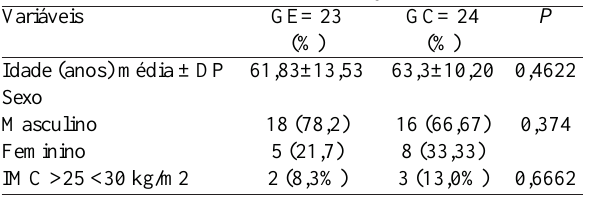
Tabela 1. Dados demográficos da população estudada.